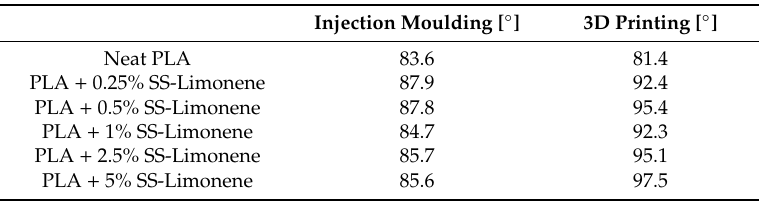
Table 3. Water contact angle [ ◦